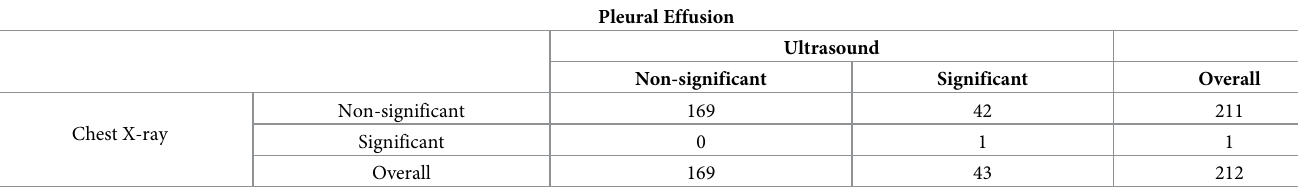
Table 4. PE: Agreement between LU and CXR by clinically oriented method (scores 0, 1–2 = non-significant; 3–6 = significant).